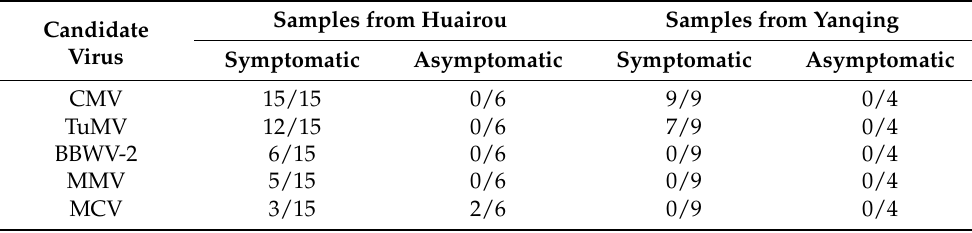
Table 2. Candidate virus detection in the